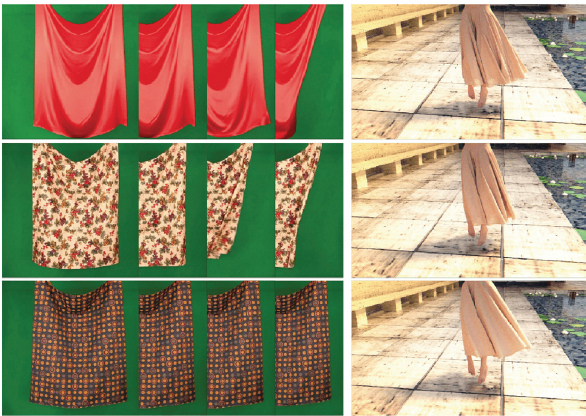
Fig. 5 Yang et al. [20] modeled clothes materials in input videos (left), and applied those materials to a simulated skirt (right). Reproduced with permission from Ref. [20], c (cid:2) The Author(s)